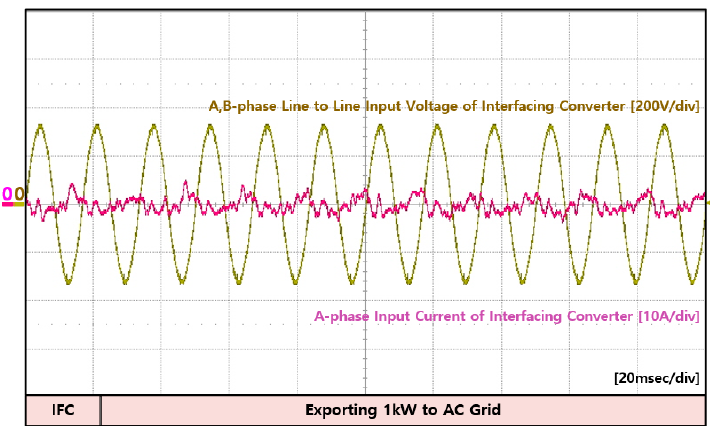
Figure 15. Experiment waveforms of interfacing converter at AC grid in mode 2.